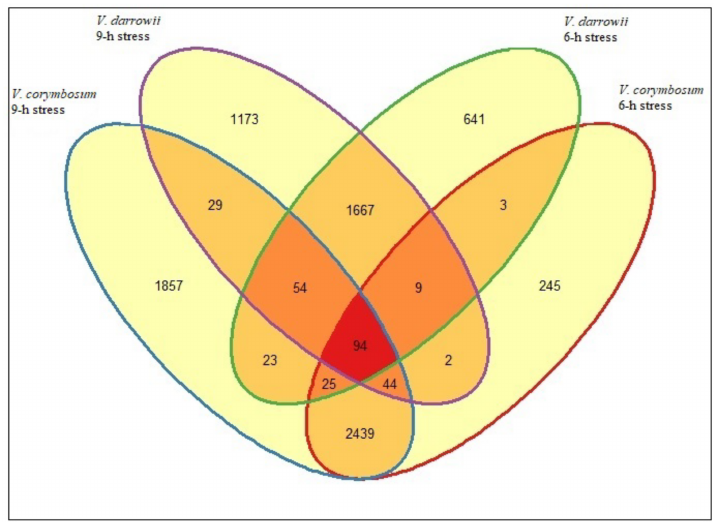
Figure 2. Venn diagram comparing the number of genes with statistically significant differential expression in response to heat stress at 6 and 9-h in V. darrowii and V. corymbosum species. In the ER, newly synthesized peptides are folded into proper functional proteins with the help of chaperone proteins. Chaperones play an important role in the repair of the misfolded proteins and homeostasis. In plants, HSPs/chaperones play an important role under heat stress and are responsible for the events of protein folding, assembly, translocation, and degradation [31,32]. We found an upregulation of sHSF/HSPs and molecular chaperones ( Hsp90 , Hsp70 , Hsp40 ) with increased exposure to heat stress in both blueberry species (Figures 3 and 4). Moreover, we observed the upregulation of other genes involved in protein processing in ER and misfolded protein repair in both the species at 6-h stress, but a downregulation pattern for most of these genes was observed at 9-h stress in V. darrowii . In contrast, other genes maintained upregulation patterns for protein processing in ER and ubiquitination ( Derlin , Sec 61 , OS9 , Ubx , p97 , Ufd1 , UbcH5 , HRD1 , SAR1 ) in V. darrowii at 6-h stress, and a few specific genes showed upregulation ( Ubx , Ufd1 , and Sec23/24 , cull ) and downregulation ( eLF2 ) patterns at 9-h stress. Previous studies reported DEGs involved in protein processing in ER such as protein homeostasis (sHSF), luminal chaperon ( NEF, GRP94 ), chaperon binding protein (BiP), protein folding machinery ( CRT , CNX , PDIs , UGGT , HSPs), protein translocation ( Sec 61, 23/24), and ubiquitination ( Derlin , OS9 , Ubx , p97, Ufd1 , UbcH5 , HRD1 , SAR1 ) and other mechanisms involved in the heat stress response in plants [33–37]. The differential expression patterns of protein processing genes in ER suggest a prevalence in differential response and possible protein homeostasis and repair mechanisms under heat stress in blueberry